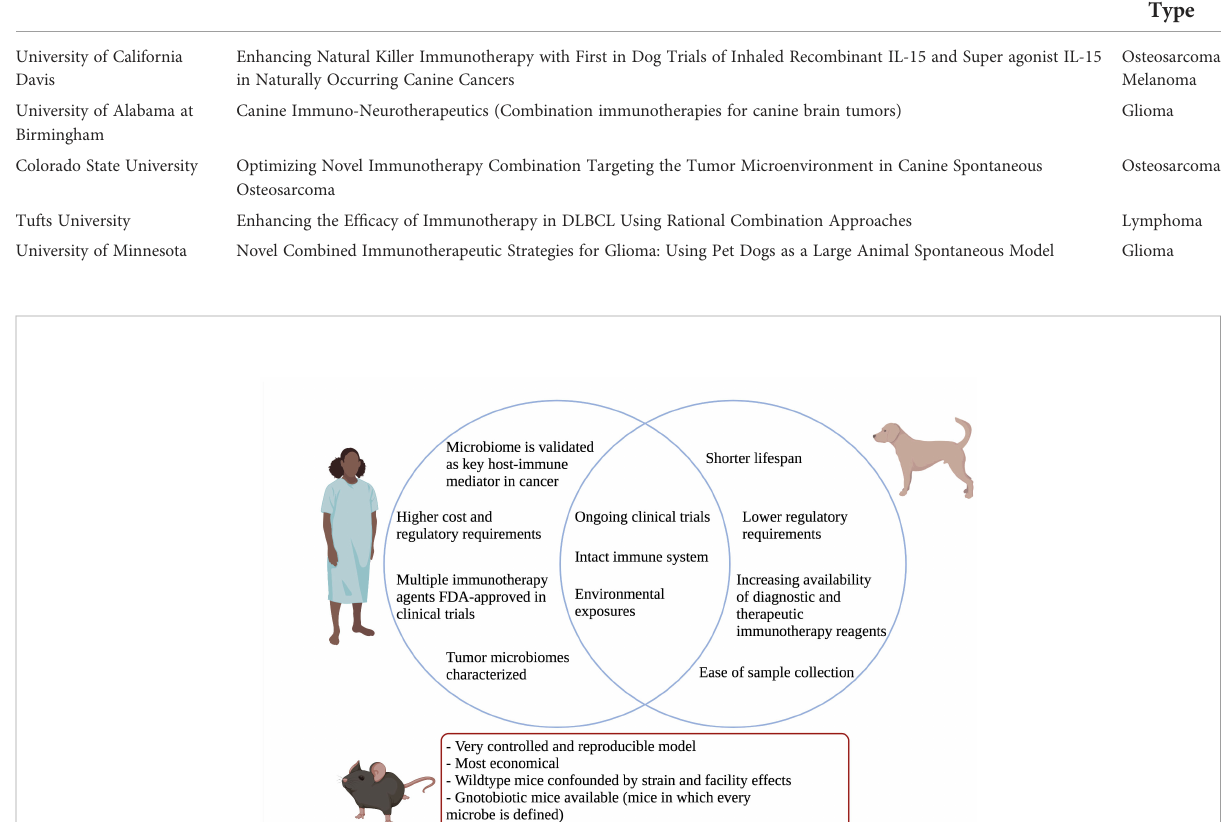
TABLE 1 Ongoing Clinical Trials in Dogs.